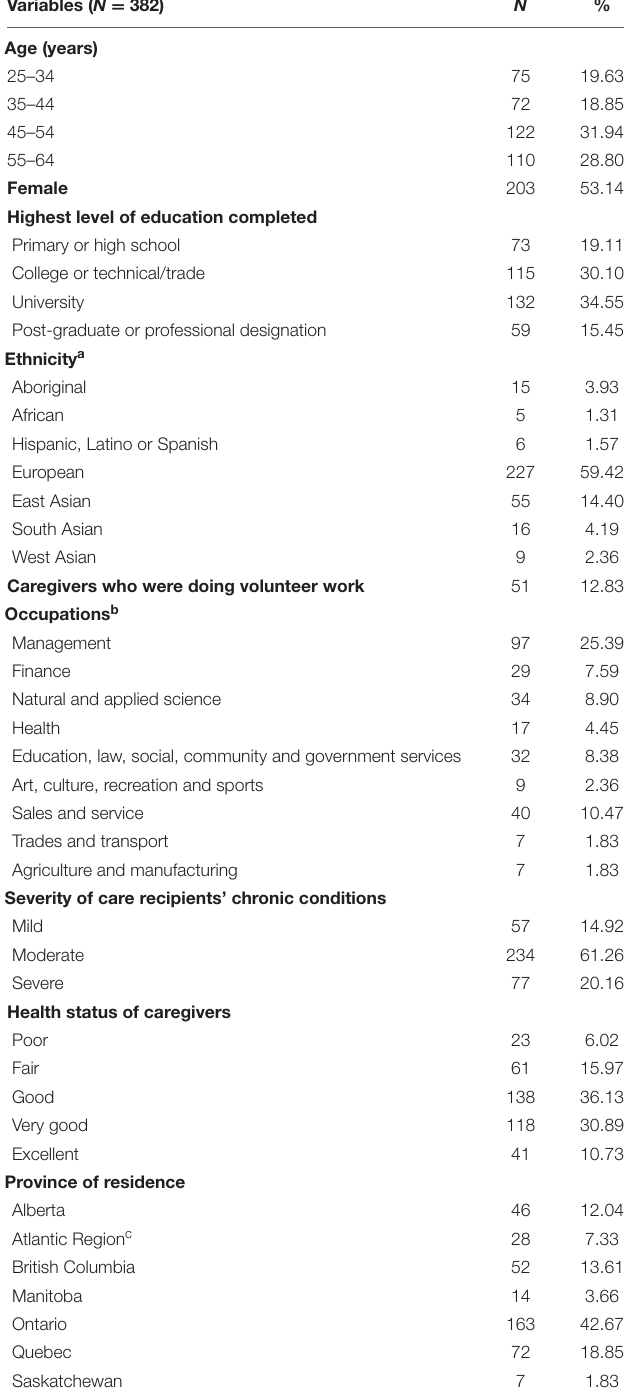
TABLE 1 | Caregiver participant